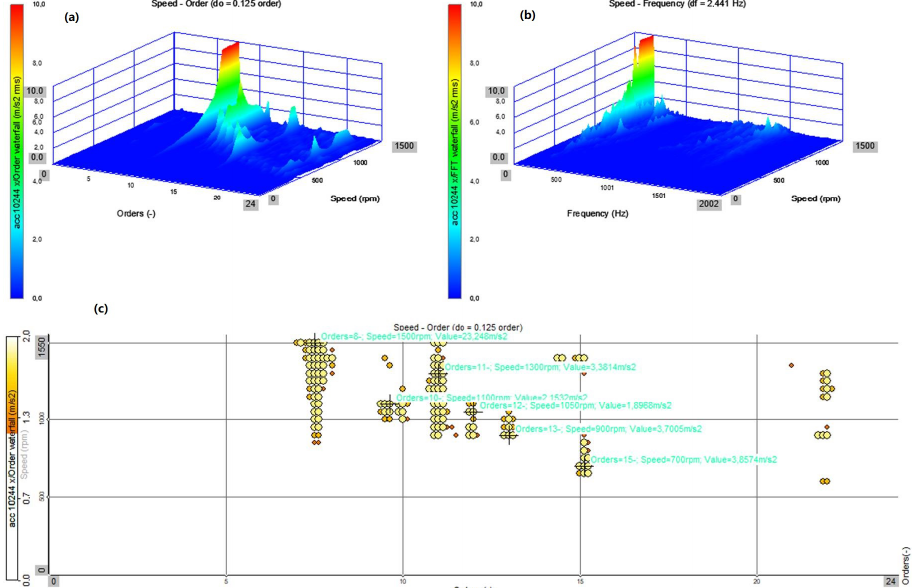
Figure 14. Start-up—flexible coupling (right rotation): ( a ) 3D view on the plane: order–rotational speed (rpm); ( b ) 3D view on the plane: frequency–rotational speed (rpm); and ( c ) Campbell’s diagram representing the range of amplitude values divided into levels and presented as a function of the order and rotational speed